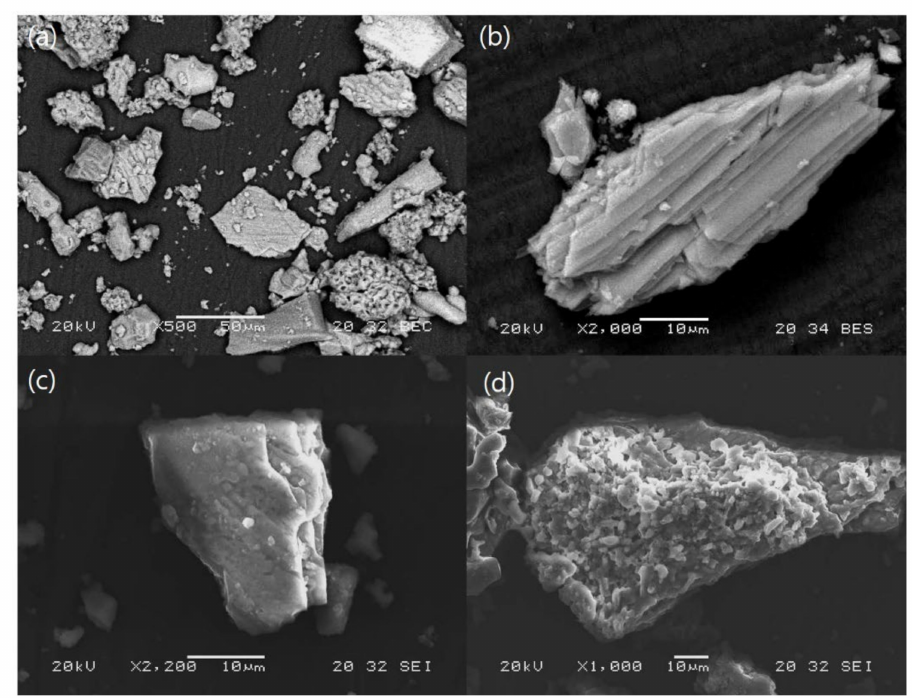
Figure 8. Scanning electron microscope (SEM) image: ( a ) Plaster. ( b ) PF. ( c , d )